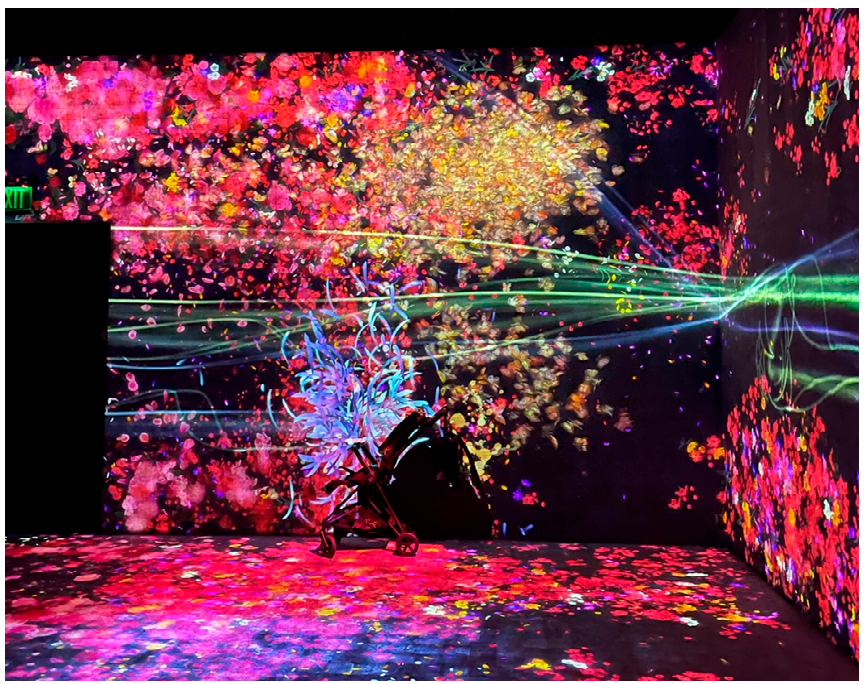
Figure 4. teamLab, Forest of Flowers and People: Lost, Immersed and Reborn, 2017/2021, Flutter of Butterflies Beyond Borders, Transcending Space, 2019/2021, and Crows are Chased and the Chasing Crows are Destined to be Chased as well, Flying Beyond Borders, 2018/2021, Asian Art Museum of San Francisco; photograph by the author, 2022.